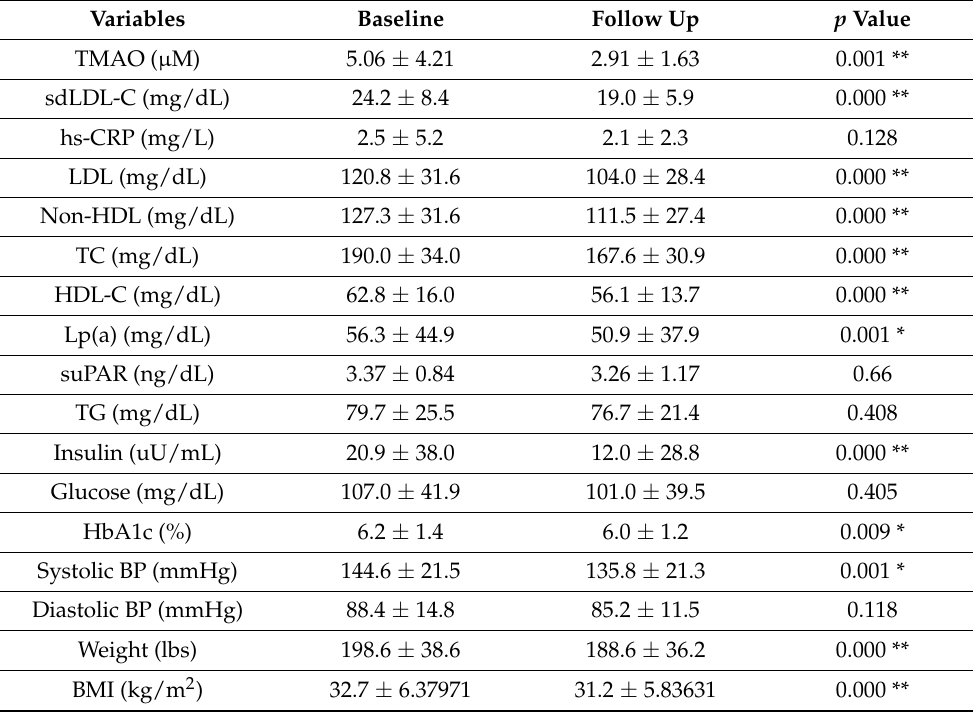
Table 2. Mean Changes in Biomarkers and Risk Factors from Baseline. Variables Baseline Follow